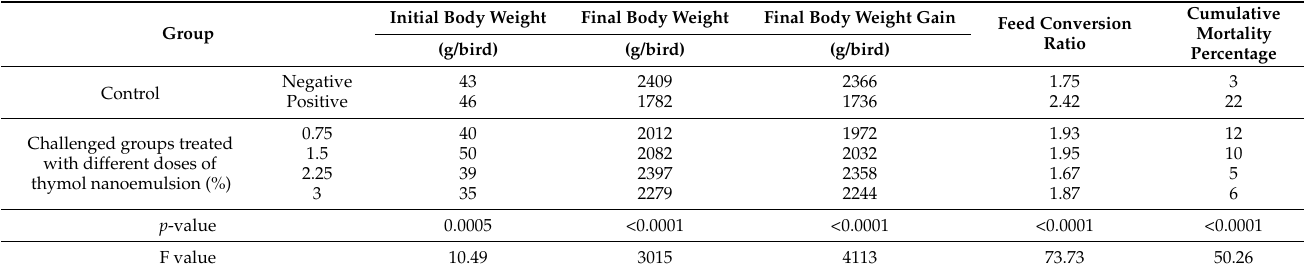
Table 1. Effects of thymol nanoemulsion therapeutic supplementation on growth performance and cumulative mortality of broiler chickens post challenge with XDR S. Enteritidis strain.